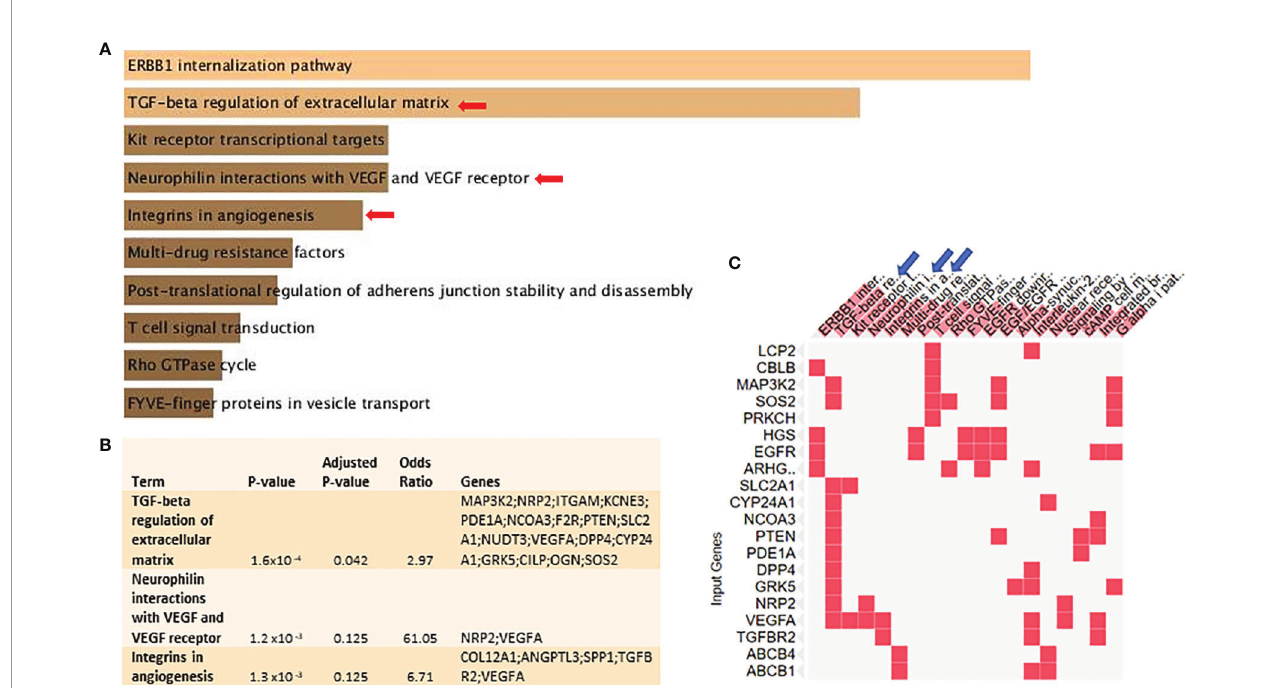
FIGURE 1 | Vitamin D signaling differentially regulates key VM-related genes and signaling pathways in BC cells: with the use of Enrichr tool, a publicly available dataset of MCF-7 cells treated with pharmacological doses of 1,25-dihydroxycholecalciferol (vitamin D3) (GSE27220) was used to identify differentially regulated genes and pathways. MCF-7 cells used in generating these data were left untreated or treated with 100 nM of 1,25-dihydroxycholecalciferol (calcitriol) (treated, n = 5; control, n = 5). (A) Top differentially downregulated pathways. (B) Pathways selected for biological validation. (C) Input genes plotted versus enriched terms. VM, vasculogenic mimicry; BC, breast